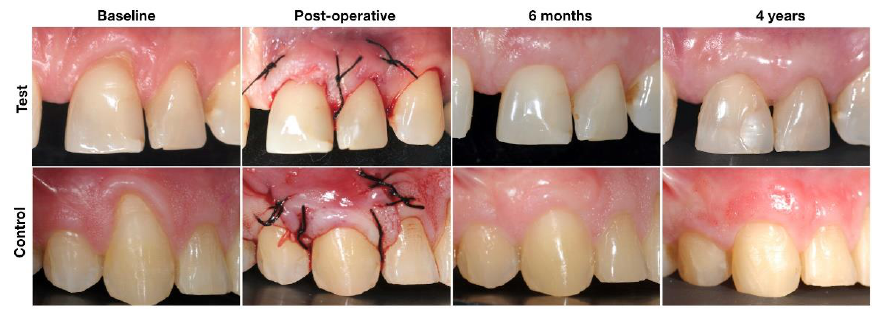
Figure 2. Surgical procedures and follow-up in Test (POT + CTG) and Control (CAF + CTG).